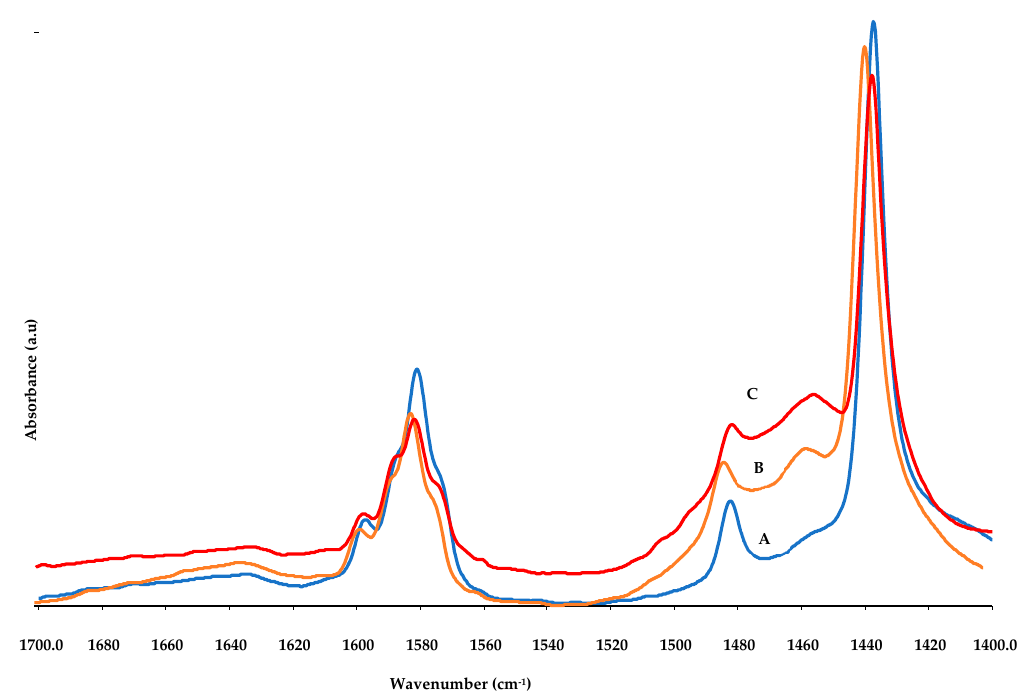
◦ C, ( B ) 550 ◦ C, ( C ) 750 ◦ C. Catalysts 2020 , 10 , x FOR PEER REVIEW